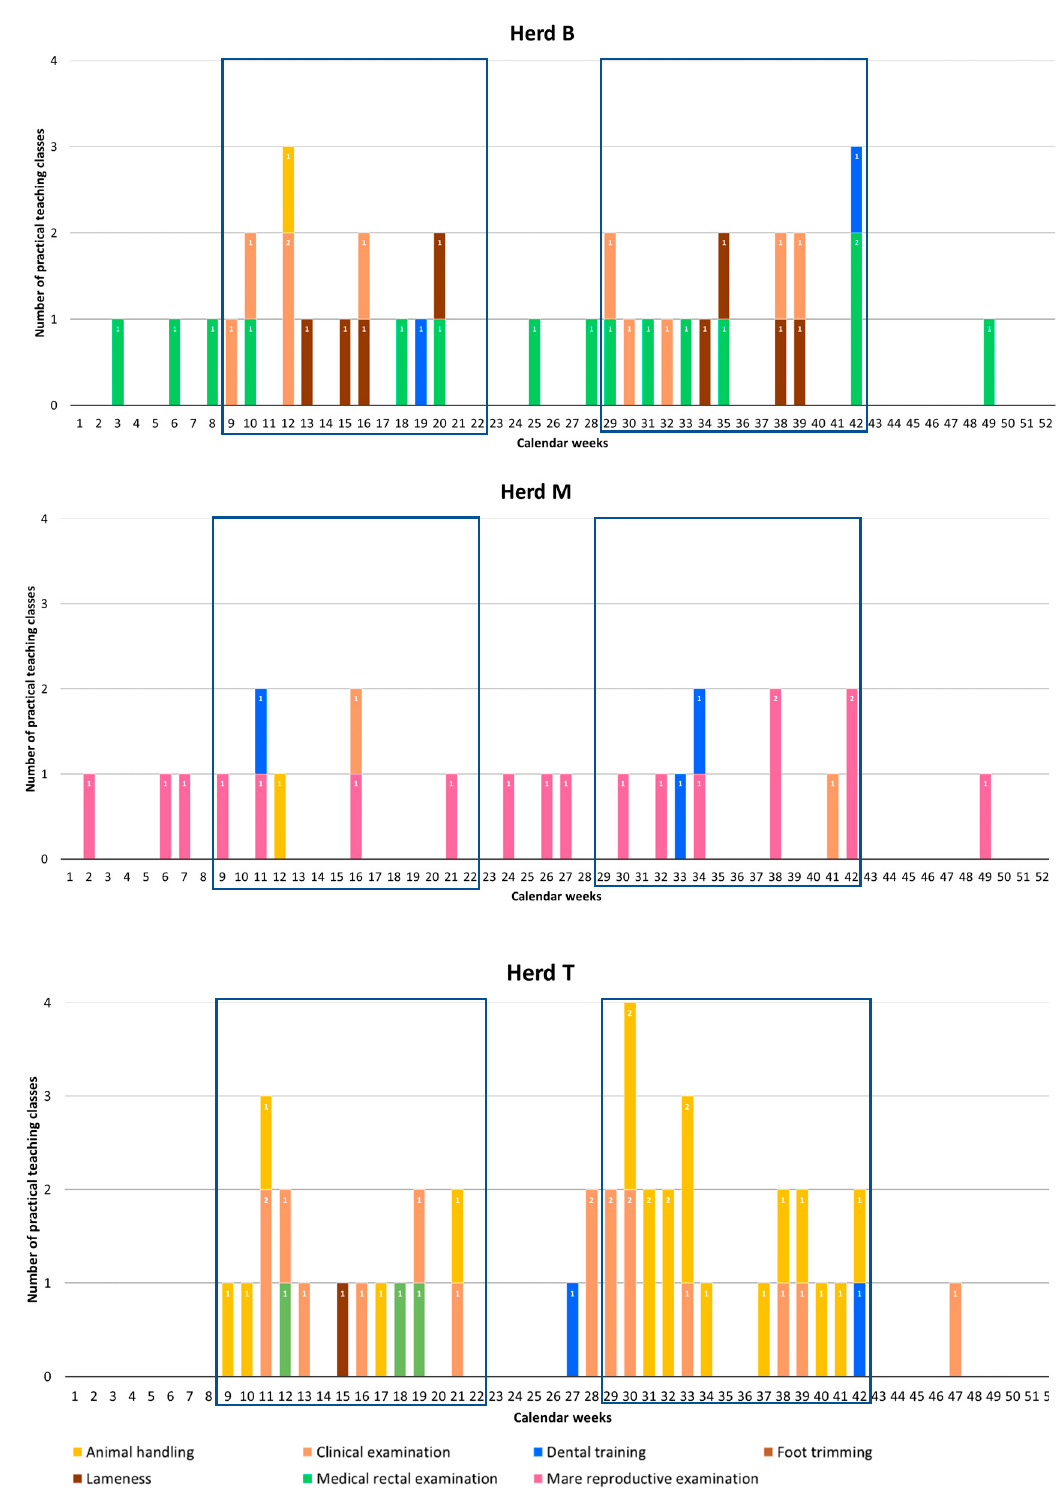
Figure 1. The numbers and types of practical teaching classes per week over the calendar year, i.e., any class for which a minimum of one horse was used for teaching per week, for each herd (B, M, and T). The blue boxes refer to the teaching semesters one and two, i.e., to weeks 9 to 22, and to weeks 29 to 42,